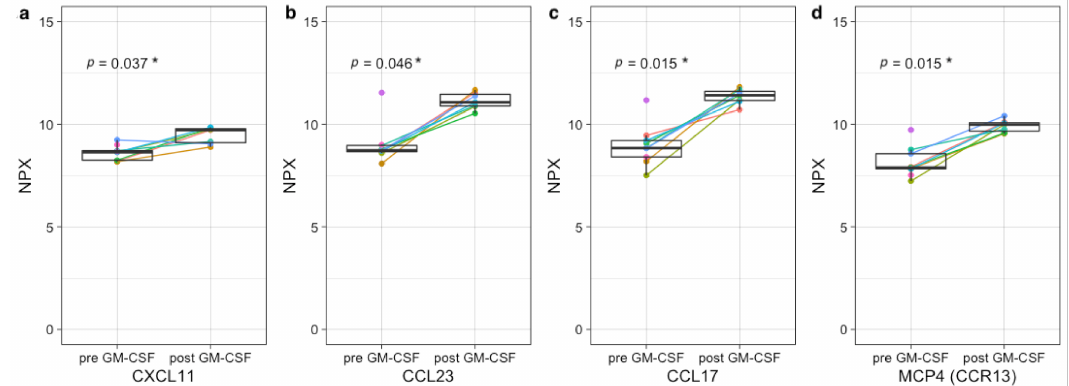
Figure 5. Upregulation of neutrophil-, monocyte-, and eosinophil-associated factors upon GM-CSF-containing immunother- apy cycles. Plasma protein concentration of CXCL11 ( p = 0.037) ( a ), CCL23 ( p = 0.046) ( b ), CCL17 ( p = 0.015) ( c ), and MCP-4 ( d ) ( p = 0.015) pre- and post-GM-CSF-containing IT cycles. Protein expression is shown as normalized protein expression (NPX). In total, 7 paired samples are shown, as two patients were monitored during all three IT cycles. Two single measurements from patients pre-GM-CSF were included, resulting in a total of 9 patients pre- and 7 post-GM-CSF. * p <